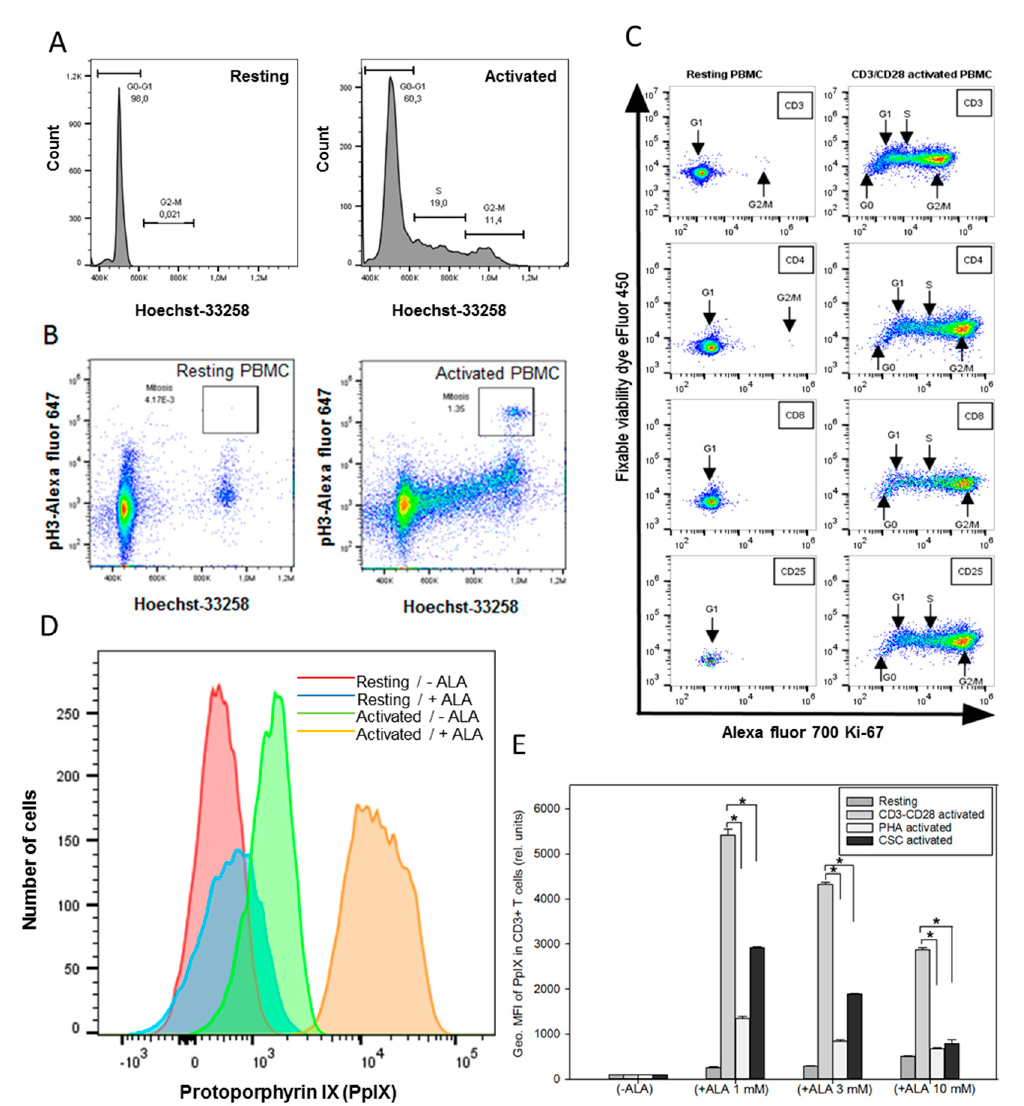
Figure 1. ( A and B ) Cell cycle and mitosis measurements. PBMCs from healthy donor were activated in vitro with anti-CD3 / CD28 antibodies for three days. Resting and activated cells were fixed in methanol and stored at − 20 ◦ C until use. Cells were stained with rabbit anti-phospho-Histone H3 followed by Alexa fluor 647 donkey anti-rabbit IgG and Hoechst 33258 dye before the measurements of cell cycle and mitosis by flow cytometry. ( C ) Resting and activated cells were divided into two groups and stained for CD4 / CD25 / Ki-67 or CD3 / CD8 / Ki-67 + fixable viability dye. ( D ) ALA-induced PpIX in resting and activated CD3 + T cells. Histograms of PpIX fluorescence in resting cells and anti-CD3 / CD28 activated cells with (24 h of ALA incubation) and without ALA were compared; ( E ) e ff ects of T cell activation protocols on ALA-induced PpIX production. Healthy donor PBMCs were activated in vitro with anti-CD3 / CD28 for three days or overnight with phytohemagglutinin (PHA) or cell stimulation cocktail (CSC), and then incubated with ALA for 24 h before the measurement of the PpIX content in CD3 + T cells by flow cytometry. The geometric mean fluorescence (Geo. MFI) intensity of PpIX was used to compare various groups. * p <